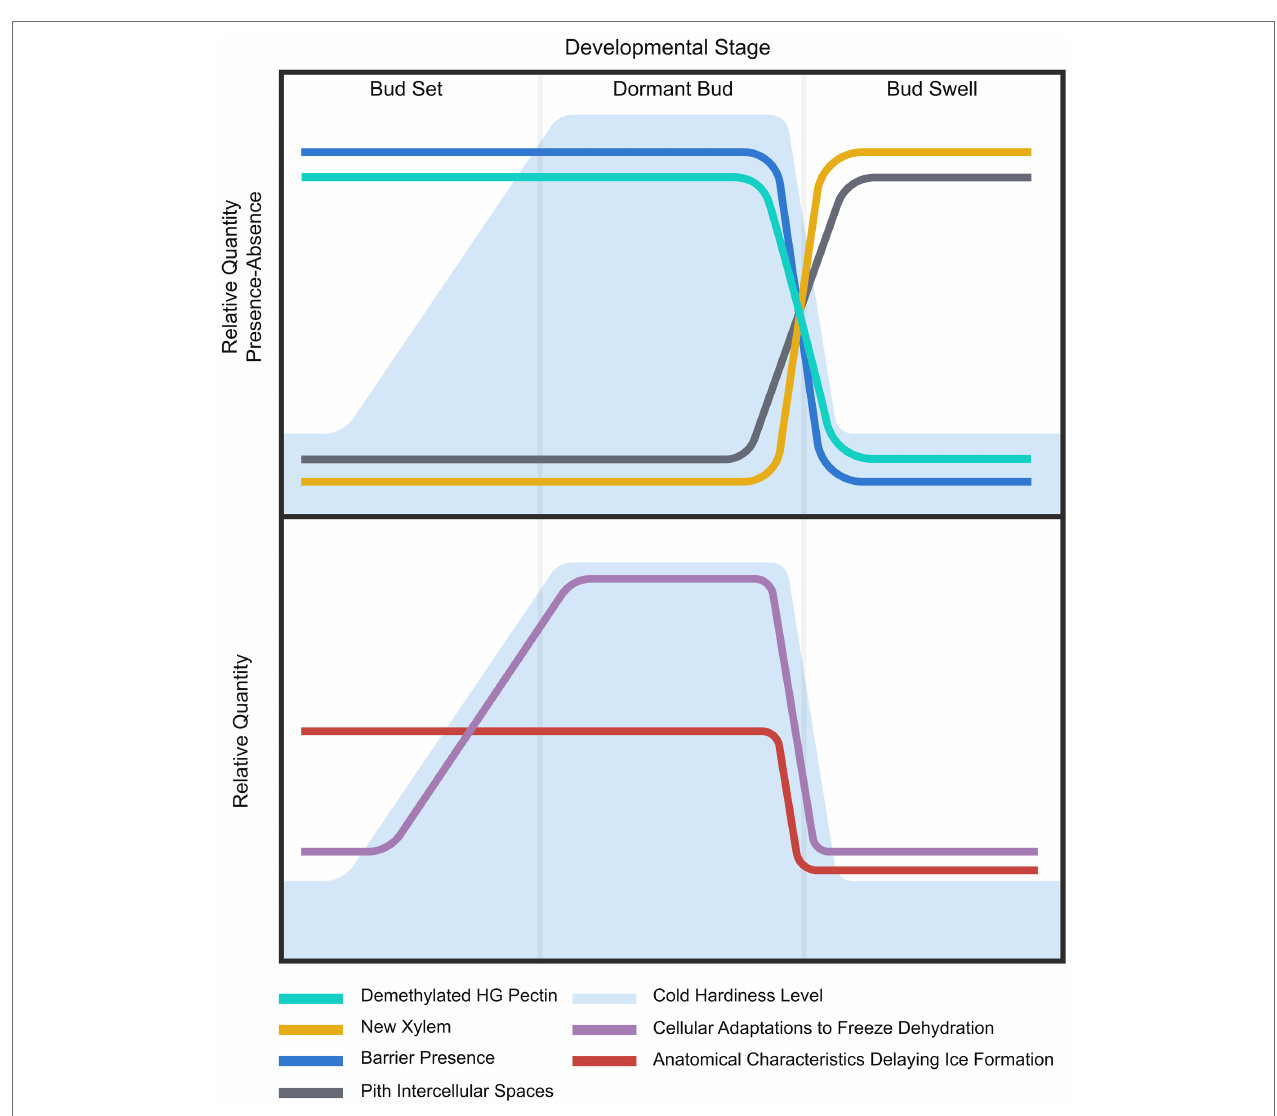
FIGURE 9 | Summary of results and proposed hypothesis. (Upper) Lines depict general seasonal trends of evaluated elements considered part of the changes in cold hardiness in Vaccinium macrocarpon terminal buds. Background depicts variations in freezing tolerance. (Lower) Lines represent the proposed two levels of adaptations at anatomical and metabolic/cellular levels. Background depicts variations in freezing